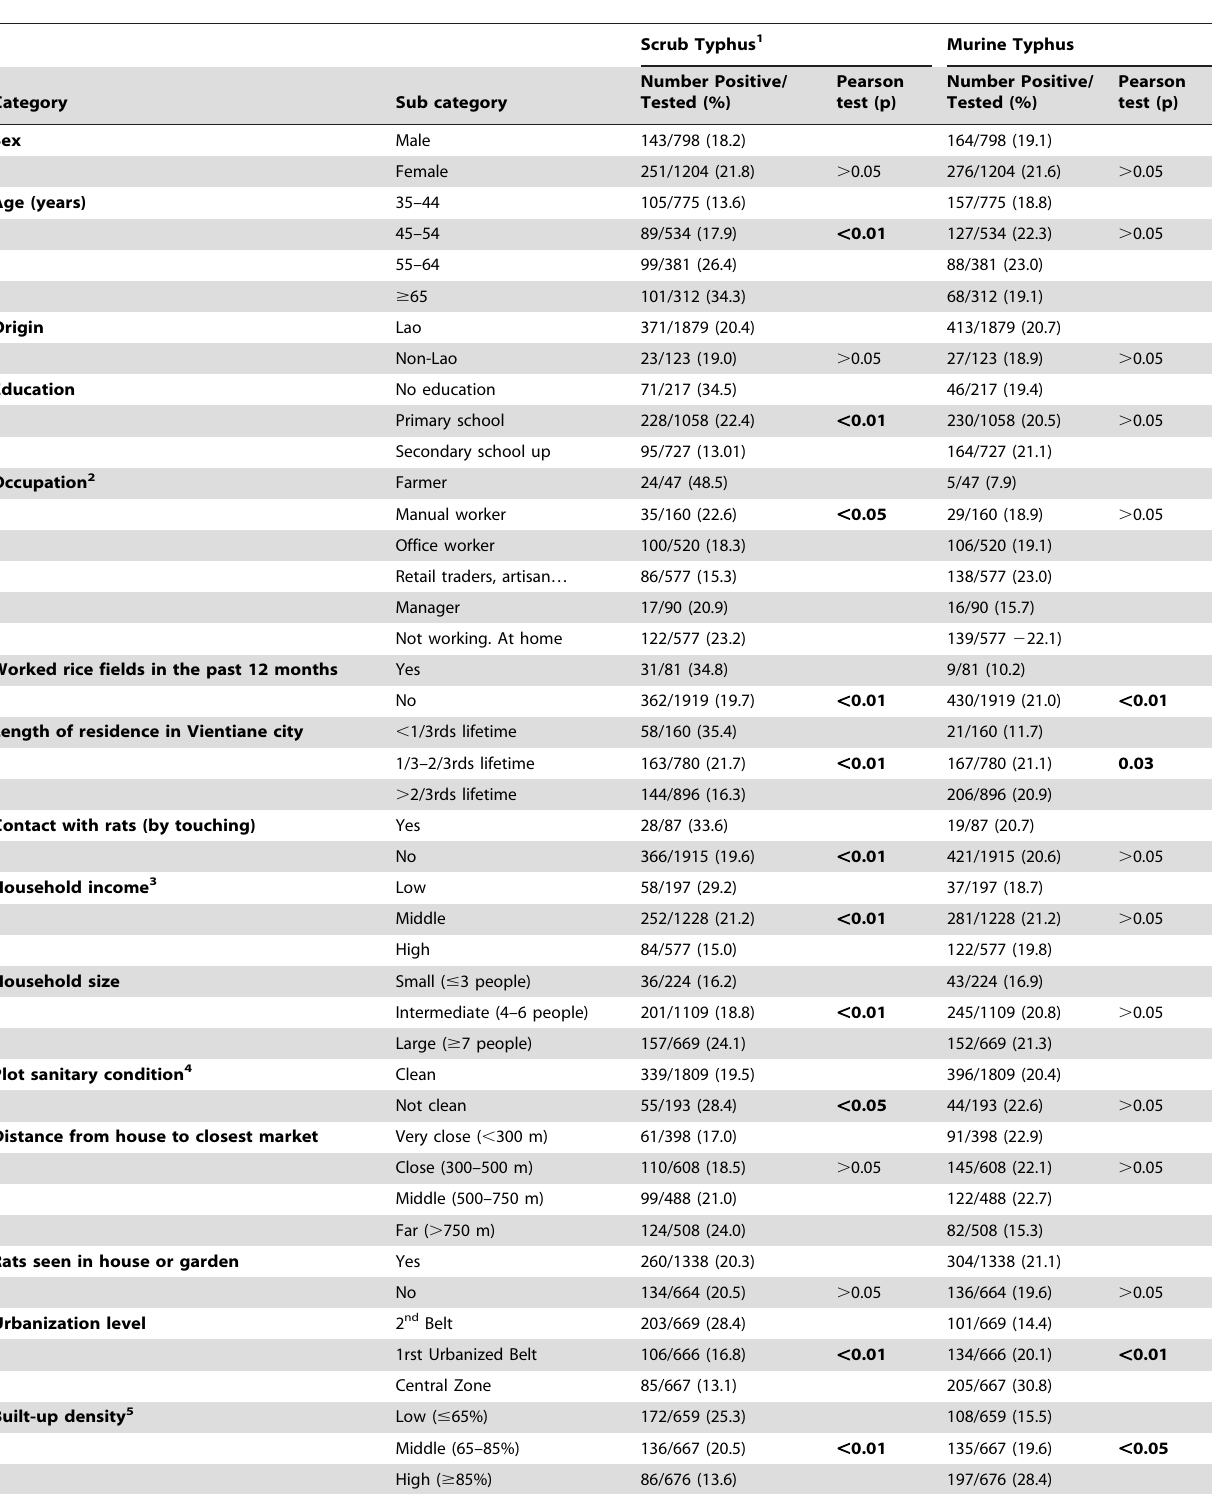
Table 3. Bivariate analysis of factors associated with IgG positivity against scrub and murine typhus (Vientiane city,